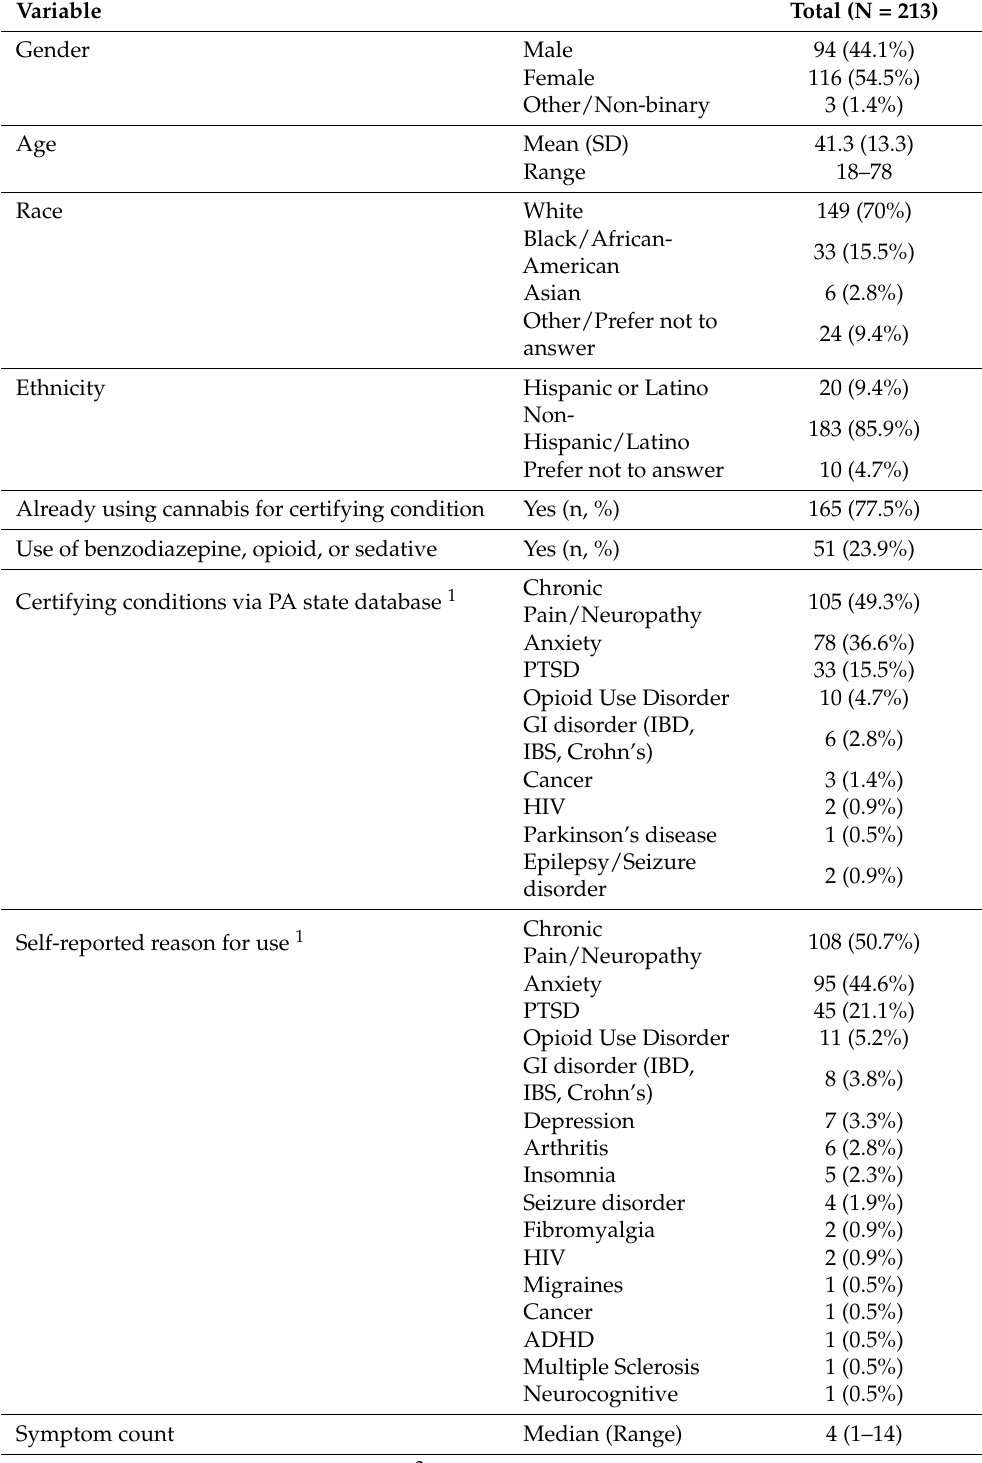
Table 1. Participant